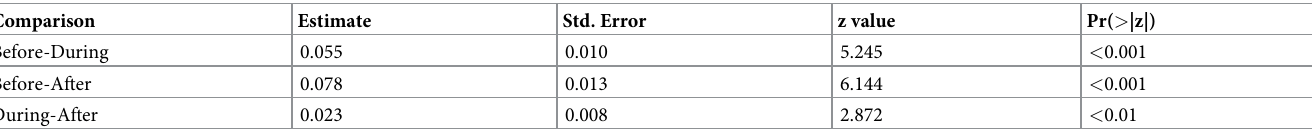
Table 1. Results of Tukey post hoc tests for multiple comparisons of ND means for the different road construction phases. Comparison Estimate Std. Error z value Pr( > |z|) Before-During 0.055 0.010 5.245 < 0.001 Before-After < 0.001 During-After 0.023 <